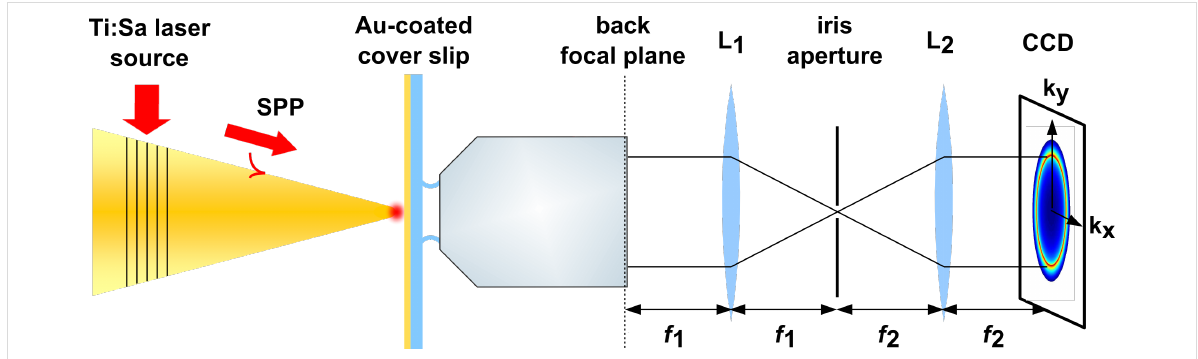
Figure 3: Setup for k-space imaging of radiation emitted from the apex of a sharp gold taper. SPP wavepackets launched via a grating coupler are adiabatically nanofocused. A gold-coated cover slip is brought into close proximity of the taper. Light scattered through the cover slip is collected with a high numerical aperture objective (NA = 1.3). The spatial Fourier transform of light in the front focal plane is imaged from the back focal plane of the objective onto a CCD camera. A spatial filter is applied in the intermediate real image